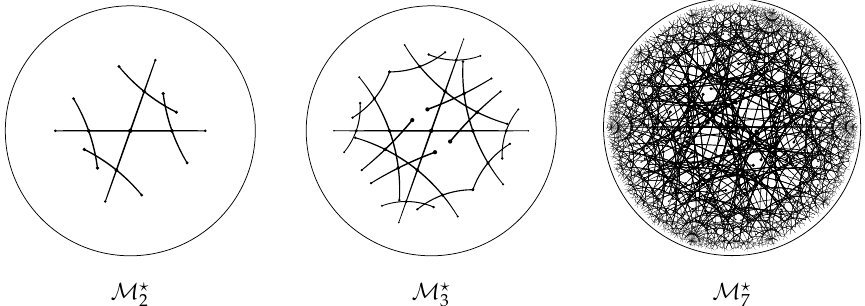
Figure A2. Depicted are three 2D cross sections of 3D Poincaré ball models of the hyperbolic space of the Lorentz group. Each dot represents one frame-grid. If two dots are connected by one line, they are interlaced, as previously described, corresponding to a Lorentz boost with a rapidity w = ln ( 2 ) . In ) and its mirroring are shown. In the second disk, two hyperbolic the first disk, the angle of arccos ( 1 3 hexagons have formed incidentally. In the third disk, various horocycles and hypercycles emerged. We show one further disk, M (cid:63) , in greater detail in Figure 9